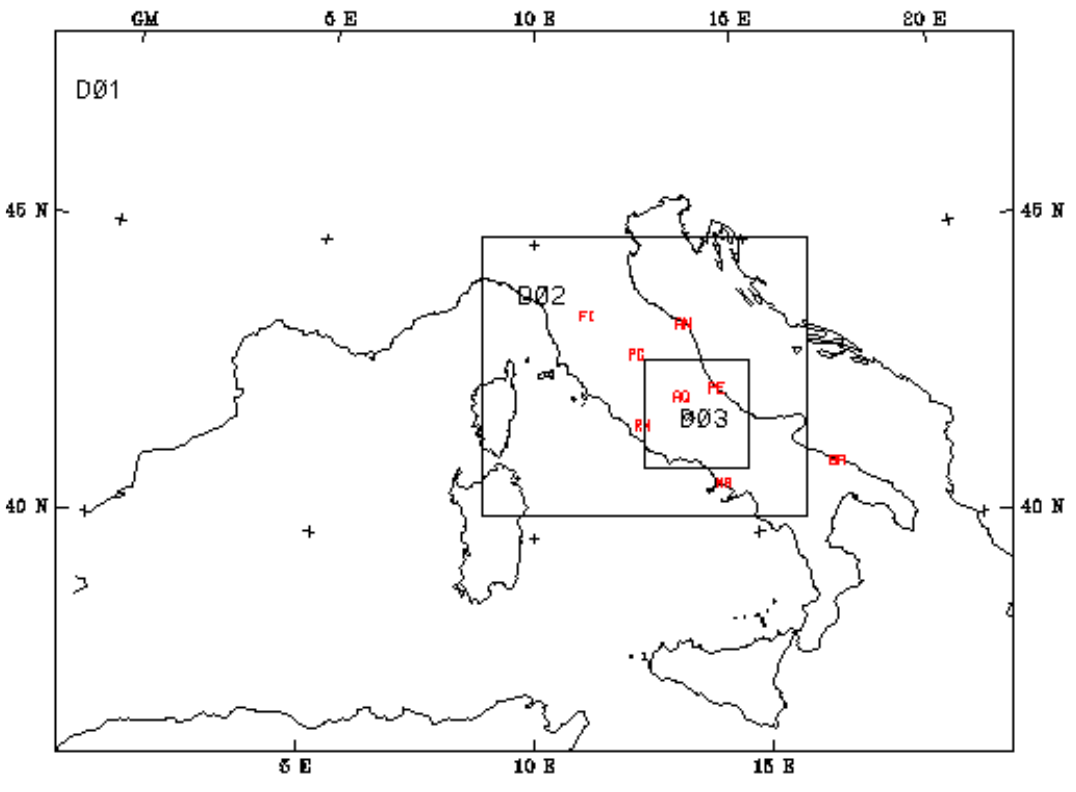
Fig. 1. Triple-nested domain used for the